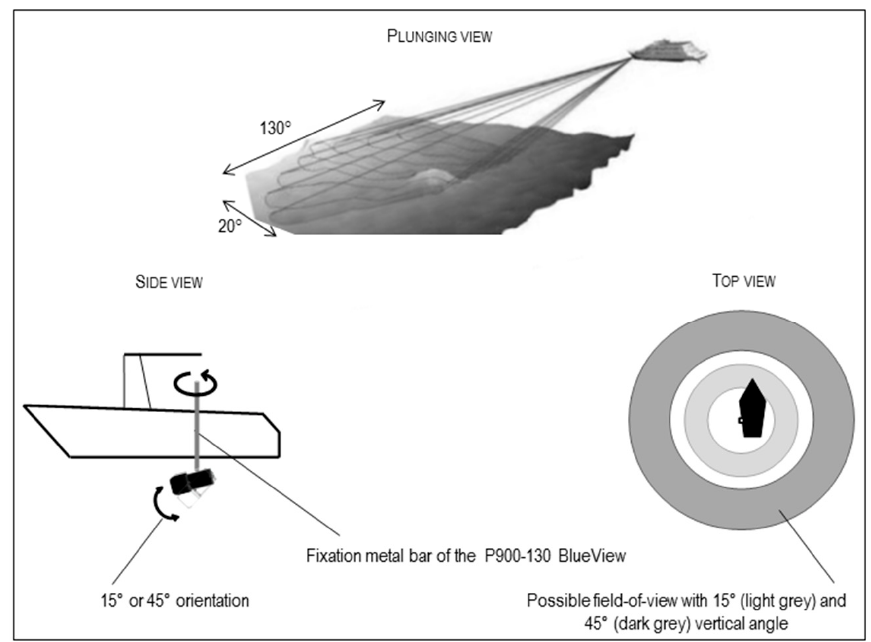
Figure 2. Diagram of the P900-130 BlueView acoustic camera installation on a boat and its field-of- view for demersal fish survey in French Guiana.